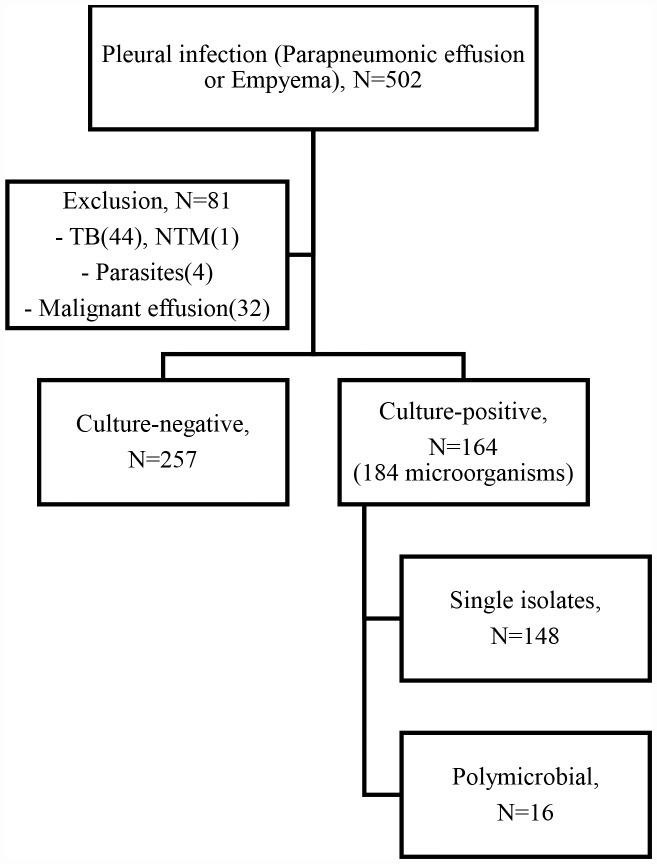
A flowchart of patient enrollment.A total of 502 patients were initially recruited. Following the exclusion of 81 patients, 421 patients were finally included in this study. These were classified into two groups, according to whether cultures were positive or negative. The 164 culture-positive patients were further divided into two groups (single isolates or polymicrobial infection). TB = Tuberculosis, NTM = Nontuberculous mycobacterium.